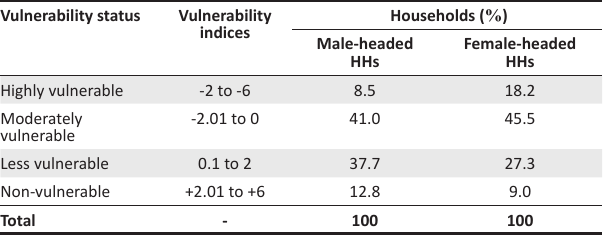
TABLE 6: Vulnerability status of male- and female-headed